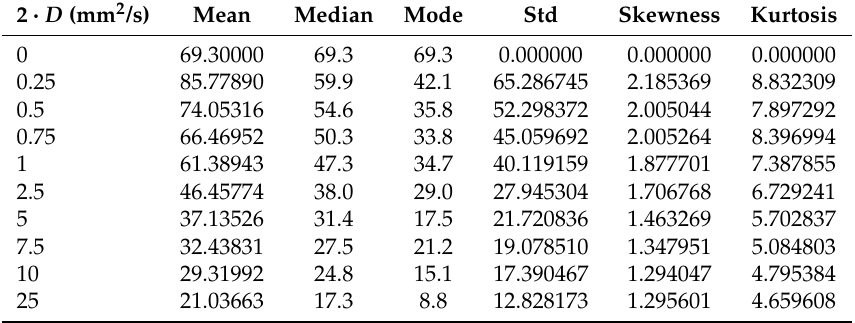
Statistics for the timing of brine shrimp agents entering the blue zone by diffusivity. All values are given in units of seconds, and both skewness and kurtosis are calculated as Pearson standardized